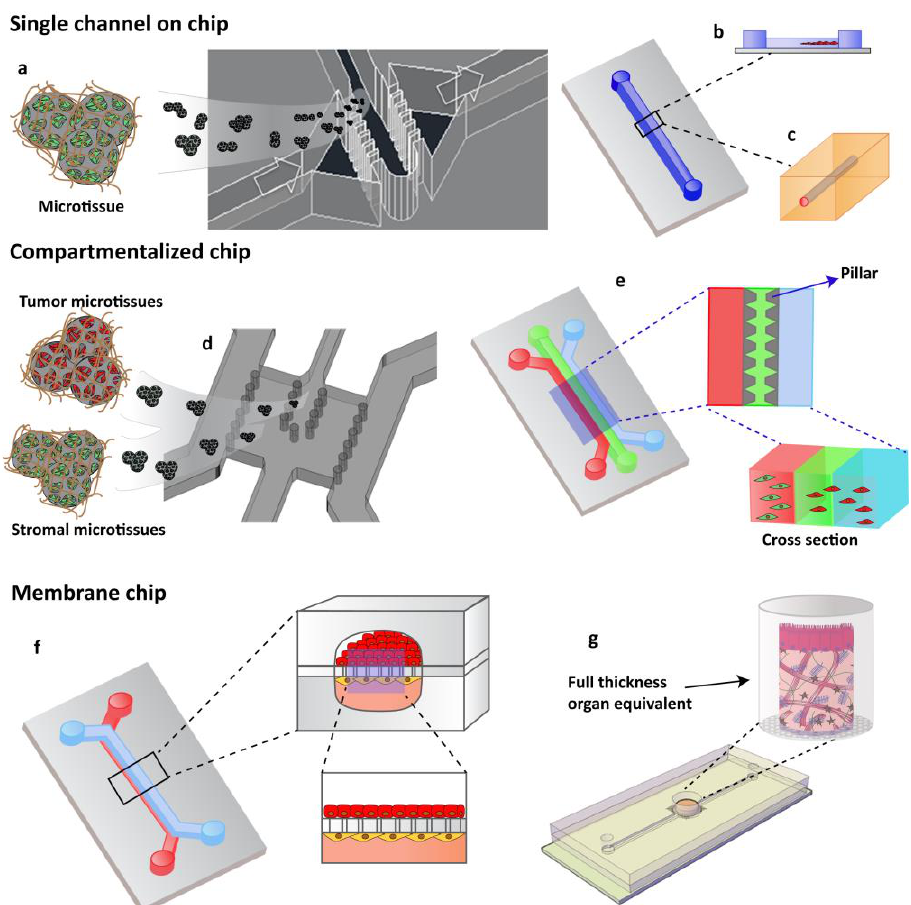
Figure 2. OOCs designs with different cell culture options. ( a ) Single channels chip designed by Garziano et al. to induce the assembly of dermal microtissues and on-line monitoring the newly synthesized collagen network, by means of SHG imaging, allowing to quantify in real time the effect of perfusion flow and biochemical stimulation on the newly collagen assembly degree. Reproduced from [96] with permission from The Royal Society of Chemistry. ( b ) Lumen channel designed to model human breast cancer cells collective invasion from primary tumors in response to interstitial fluid pressure, as reported by Piotrowski-Daspit et al. [87] or ( c ) designed to mimic a microvessel within a collagen gel scaffold as reported by Pauty et al. to study VEGF-A-induced angiogenesis permeability and angiogenic inhibitors effects [76]. ( d , e ) Compartmentalized chip: In these devices, pillars are used to separate microchannels in which 3D cell culturing is possible. The microchannels are independently addressable in order to fill each channel with a specific cell population and to allow heterotypic cultures. Depending upon the design of the chip, a 3D cell culture can occur by injecting the specific cell populated hydrogel in the correspondent channel or filling the microchamber with specific 3D microtissue. ( d ) The micropillar guarantees the physical contact of different cellular species embedded in their own ECM [93] or ( e ) in an ECM-like matrix. ( f , g ) Membrane chip. These devices allow a co-culture in a series of microchannels/chambers separated by a porous membrane. This multi-layered chip type was originally developed to mimic the endo- and epithelial cell layers found in the lung by Ingber [24]. Further, different devices have been designed in order to perform 3D organotypic culture by using both ( f ) membrane or ( g ) transwell